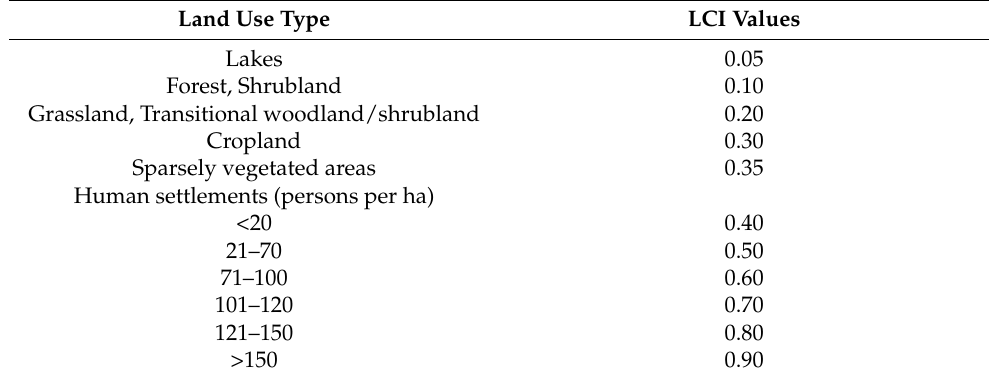
Table 1. Land cover indicator (LCI) values estimated for different land use types units in the Rocha River